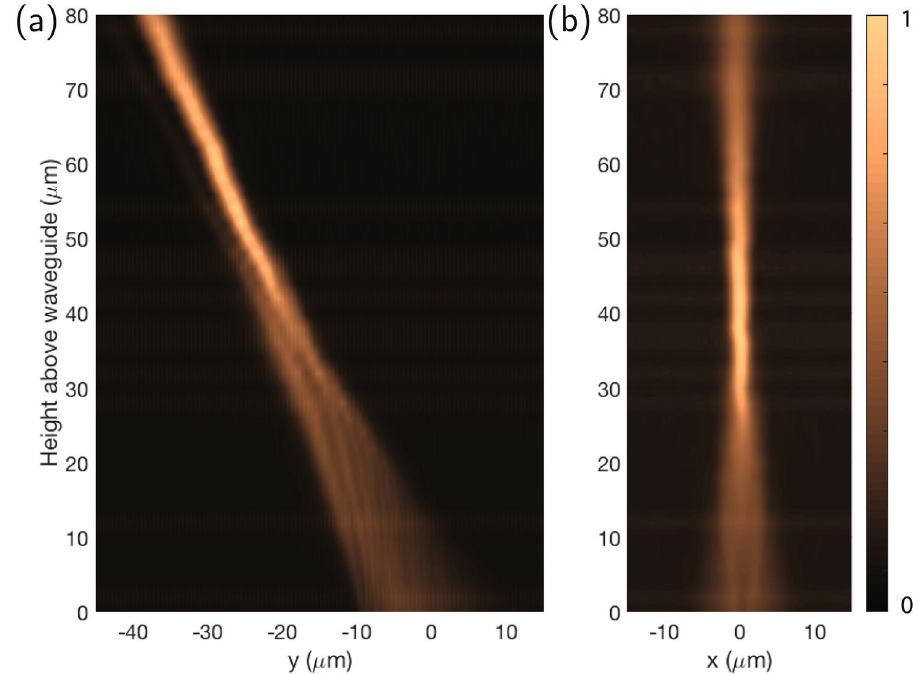
Figure 3. Measured “knife-edge”-like beam profiles ( a ) along y and ( b ) x showing focusing behavior along both